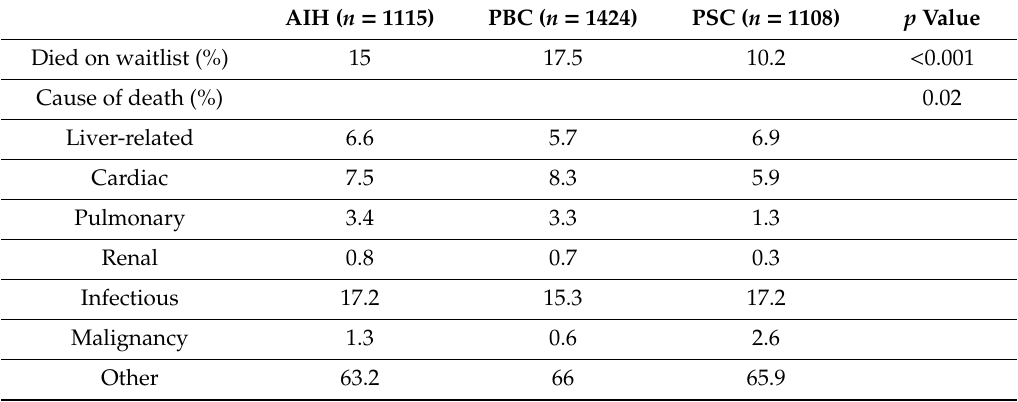
Table 2. Cause of death while on liver transplant waitlist by etiology. AIH: autoimmune hepatitis; PBC: primary biliary cholangitis; PSC: primary sclerosing cholangitis.